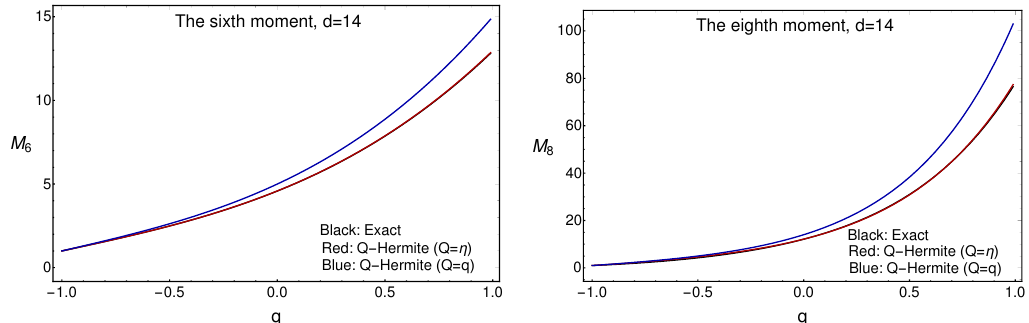
Figure 3 . The spectral density of the hyper cubic model (black curve) compared to the eighth order Q-Hermite spectral density defined in (6.7) for three different flux values as given in the legend of the figures. In the left figure φ = 0 . 57 π/ 2 , the curve resulted from a fitted a 8 (red curve) differs from the one resulted from the a 8 that is calculated by equation (6.12) (blue curve) by less than the line width of the curve’s plot, so we do not see the red curve at all. The red curve and blue curve also agree very well in the middle figure where φ = 0 . 95 π/ 2 . The deviations are larger for φ = 3 π in the right figure. 4